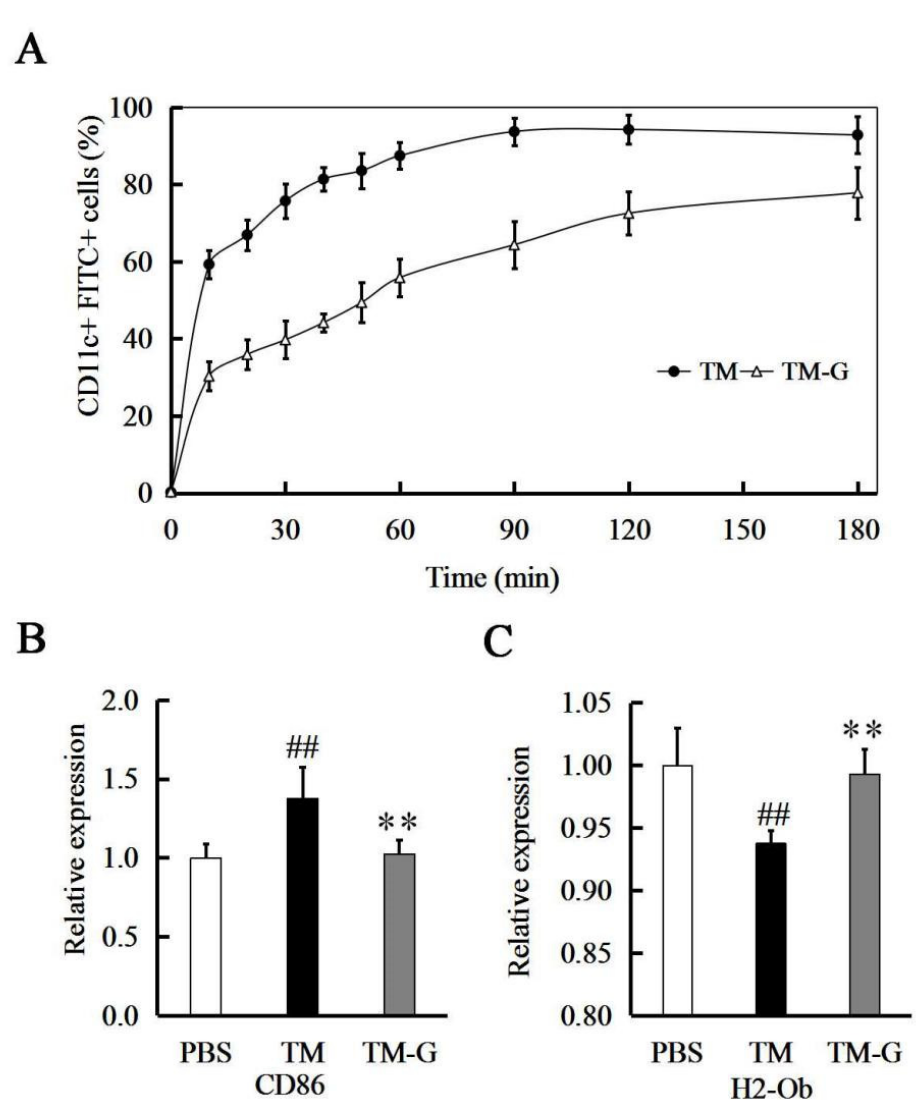
Figure 2. Allergen uptake and presentation by BMDCs: ( A ) TM-G uptake by BMDCs with different times (the gradient times were 0, 10, 20, 30, 40, 50, 60, 90, 120, and 180 min). ( B , C ) TM and TM-G presentation by BMDCs. All data are presented as the mean ± SD ( n = 3). ## p < 0.01 was used to compare with PBS group. ** p < 0.01 was used to compare with TM group.